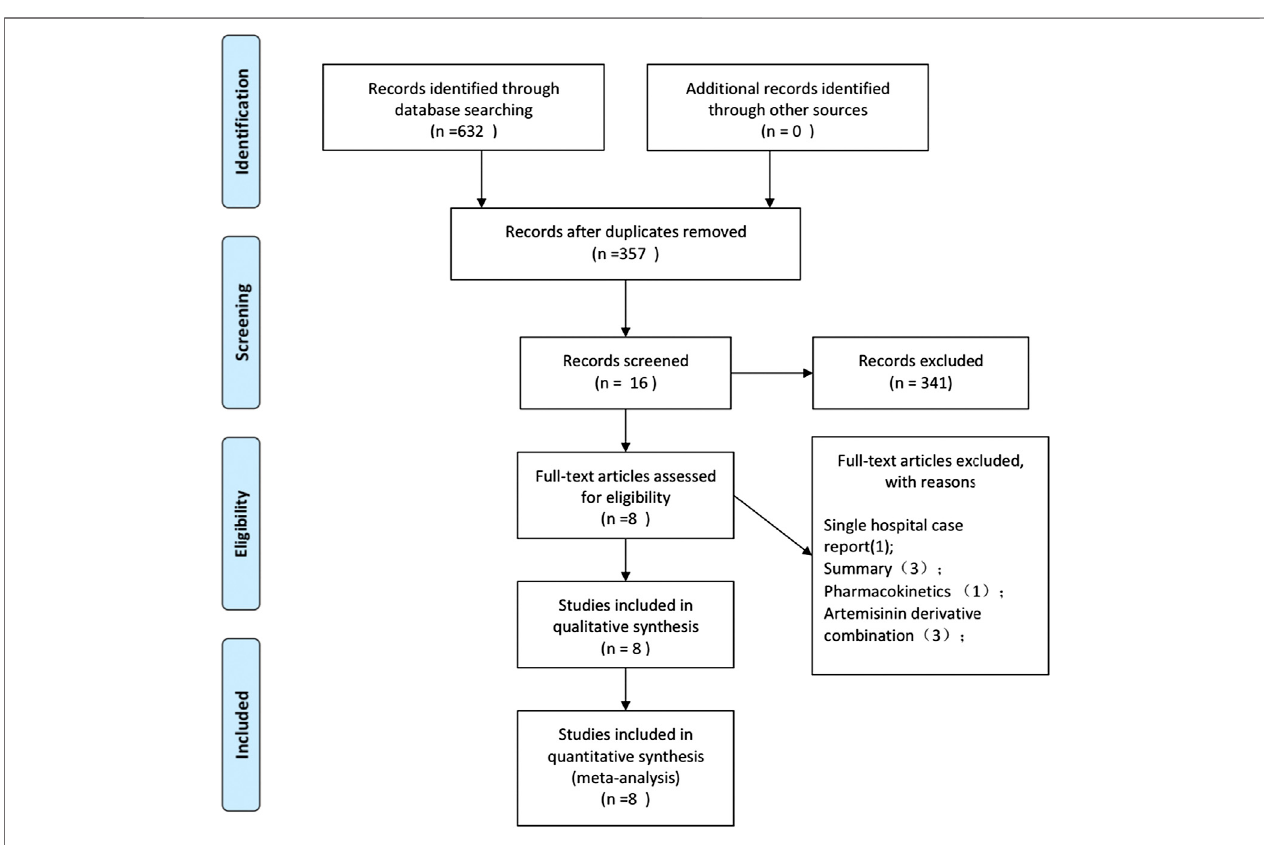
FIGURE 1 | PRISMA fl ow